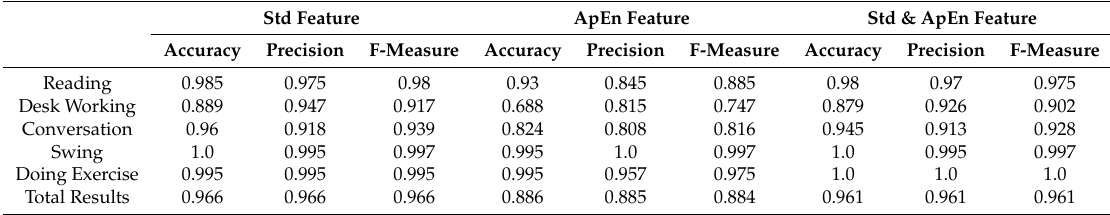
Table 7. Activity recognition for using the pressure sensor cushion.